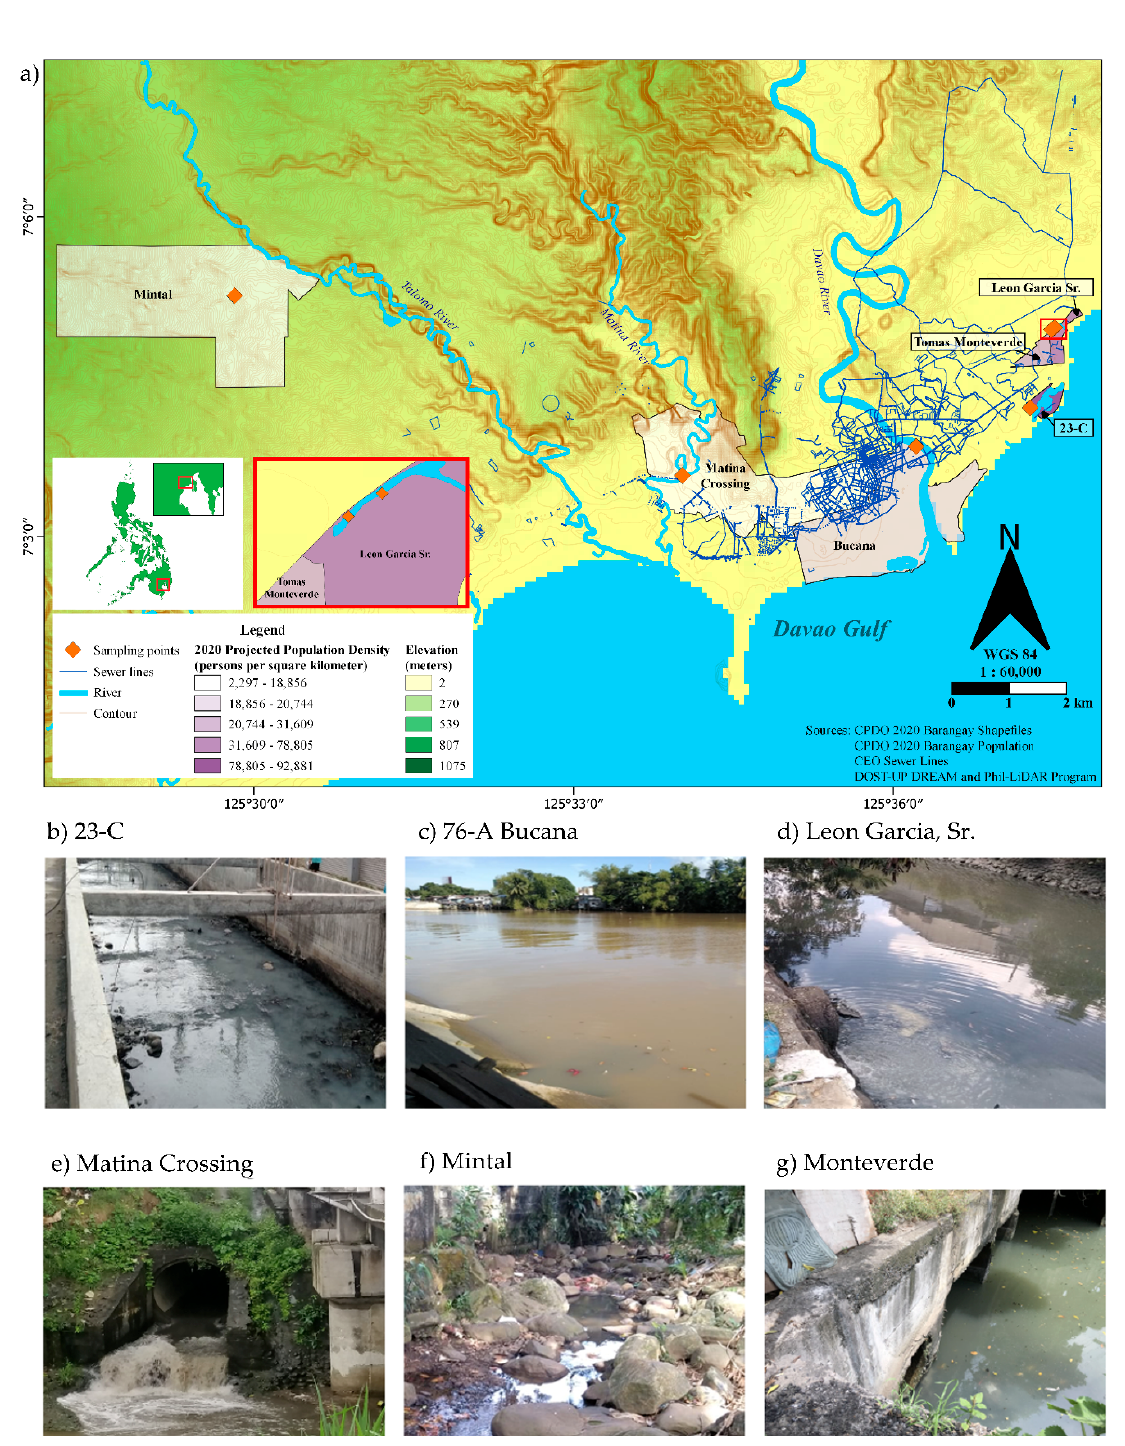
Figure 1. Wastewater outfall and sampling sites in Davao City. ( a ) Location of the six barangays and sampling sites with respect to the major draining natural bodies of water. Sampling site conditions showing the access points to sewer pipes in ( b ) 23-C, ( c ) 76-A Bucana, ( d ) Leon Garcia, ( e ) Matina Crossing, ( f ) Mintal, and ( g ) Monteverde. The sampling barangays were projected on the map using the shapefiles and 2020 Population Density data (persons/sq. km.) from the City Planning and Development Office (CPDO) of the City Government of Davao. Sewer lines (blue line networks on the map) were also obtained from the City Engineer’s Office (CEO) of the City Government of Davao. The contour lines (meters; shown in thin brown thin lines on the map) were obtained from the Department of Science and Technology, University of the Philippines Disaster Risk Exposure Assessment for Mitigation and Phil-LiDAR Program.